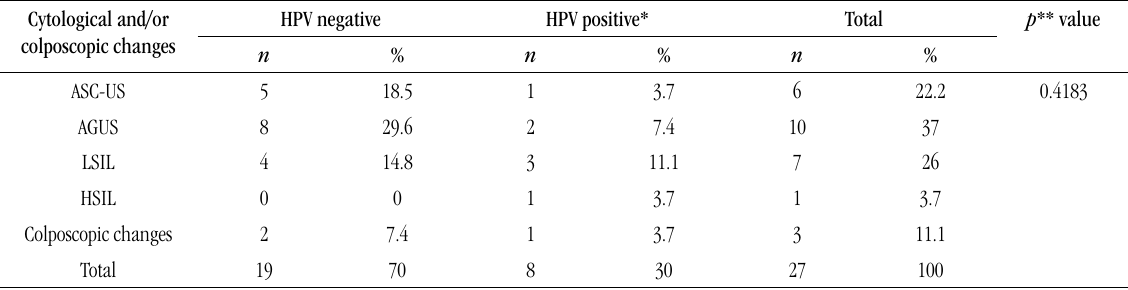
tABLE 2 – Correlation between diagnostic categories to cytologic and colposcopic examinations and HPV molecular detection Cytological and/or colposcopic